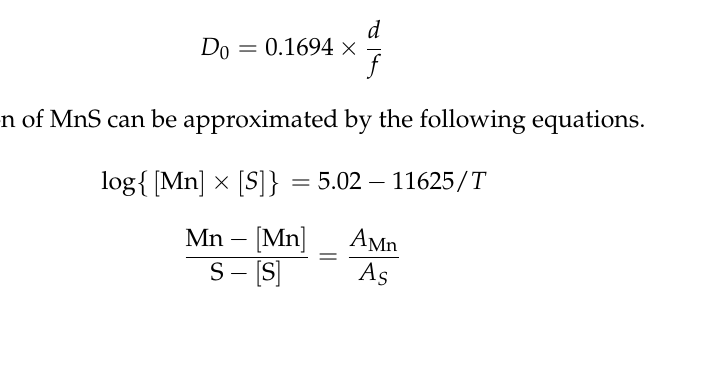
Figure 11. Precipitation amount-temperature-time (PTT) diagram of MnS precipitation.